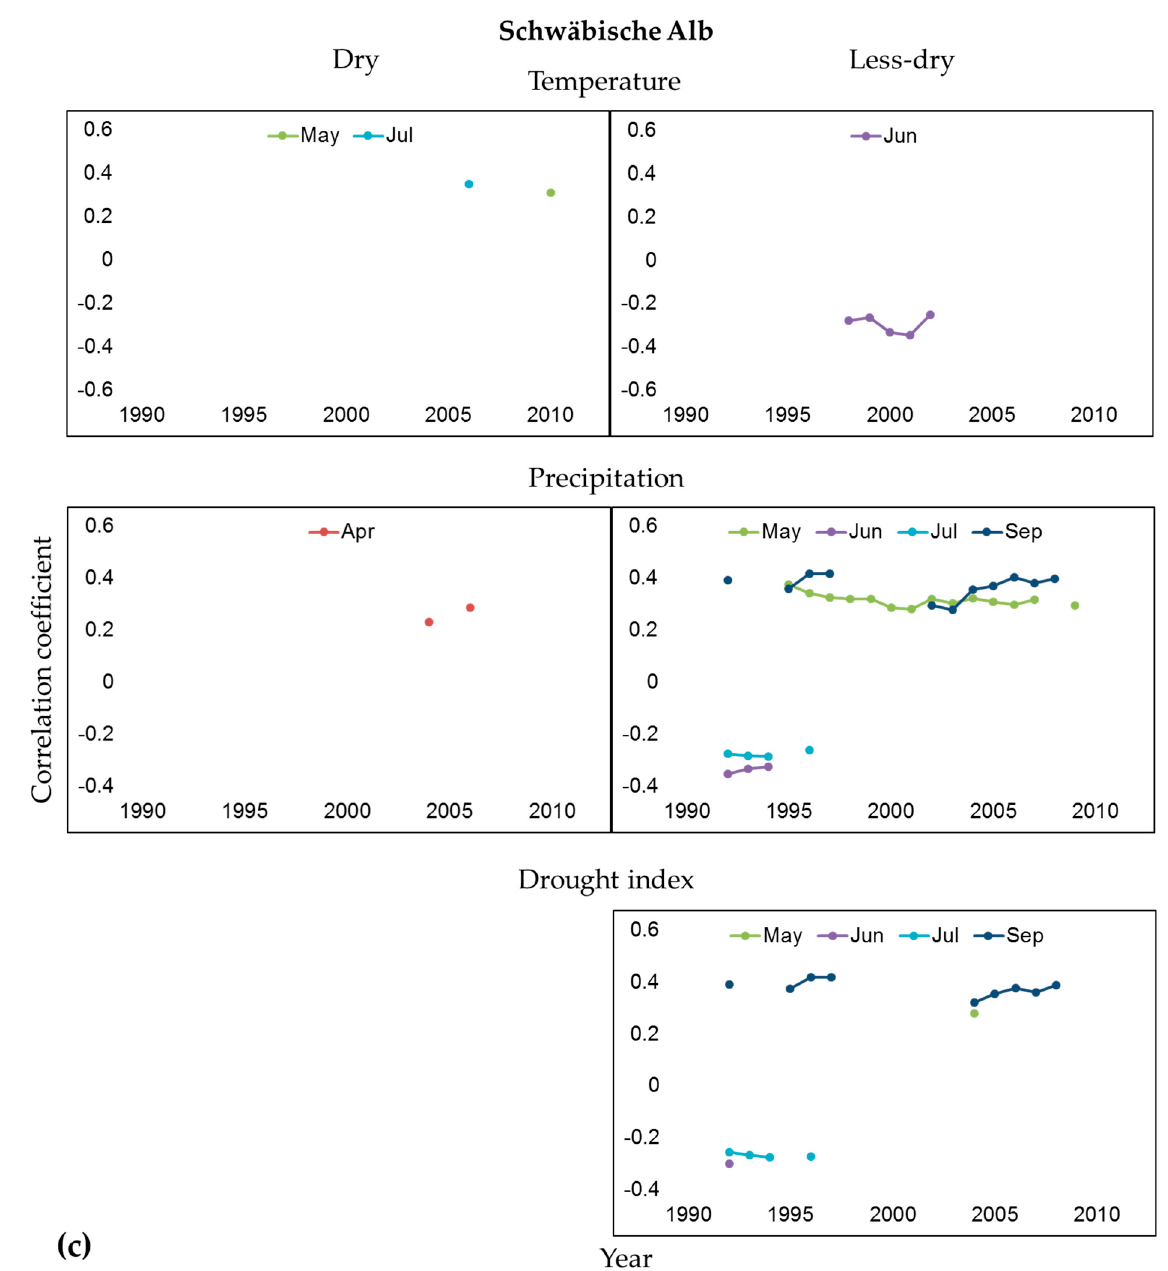
Figure 8. Correlations between radial tree growth and climatic parameters at a temporal scale separately for dry and less-dry plots in ( a ) Badenweiler, ( b ) Klettgau, and ( c ) Schwäbische Alb. Residual tree ring width indices was used as the dependent variable, whereas monthly (March to September of the current calendar year of the growth) temperature, precipitation drought index (P-PET) were used as the independent variables. Only months with significant relations are shown in the graphs. For Badenweiler and Klettgau, the correlation analysis was run for the period of 1951 to 2011 with the moving window base length of 30 years, which generated results for the period of 1981 to 2011; for Schwäbische Alb the correlation analysis was run for the period of 1961 to 2011 with the same moving window base length of 30 years which generated results for the period of 1991 to 2011.